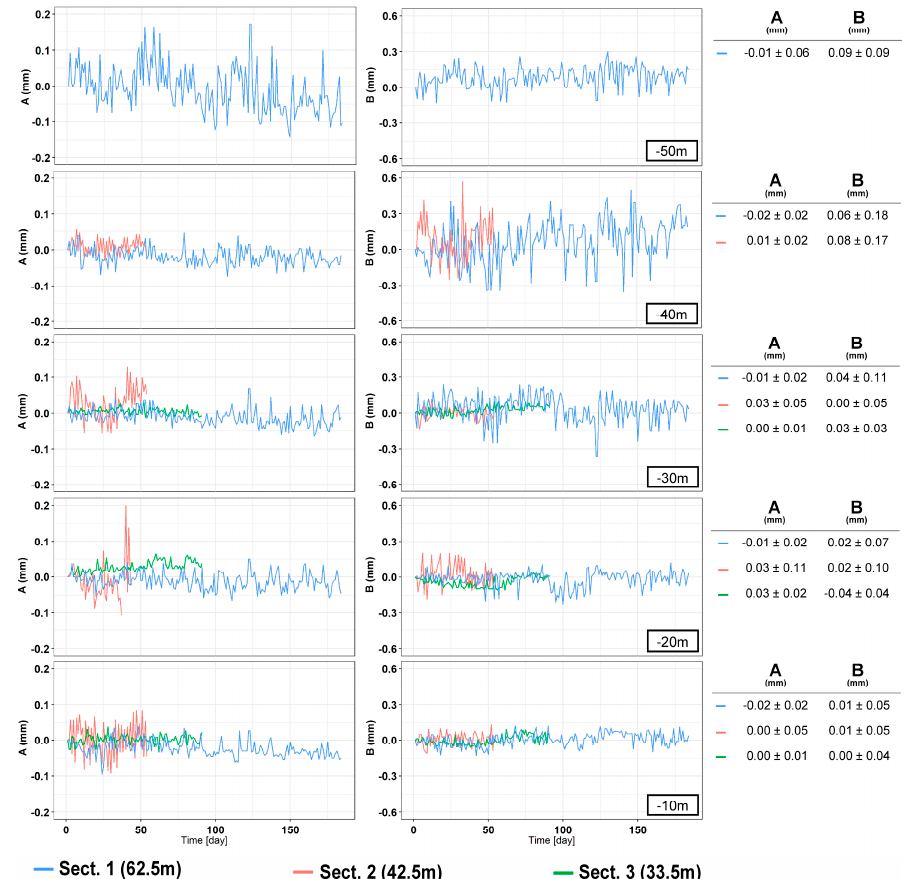
Figure 14. Time series of incremental displacements at different depths for each inclinometer